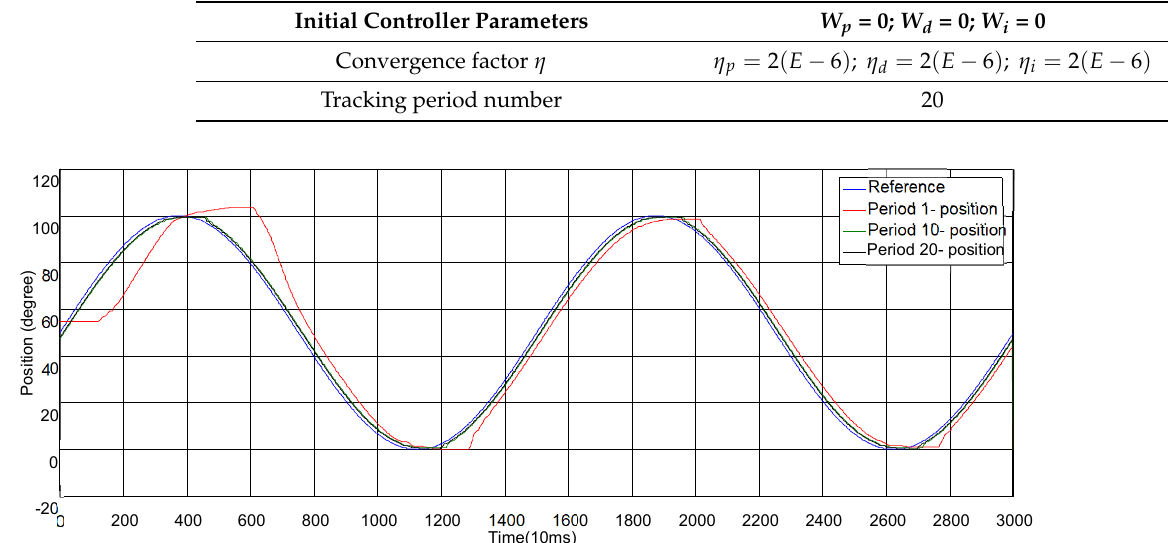
Table 5. LMS-PID controller parameters.